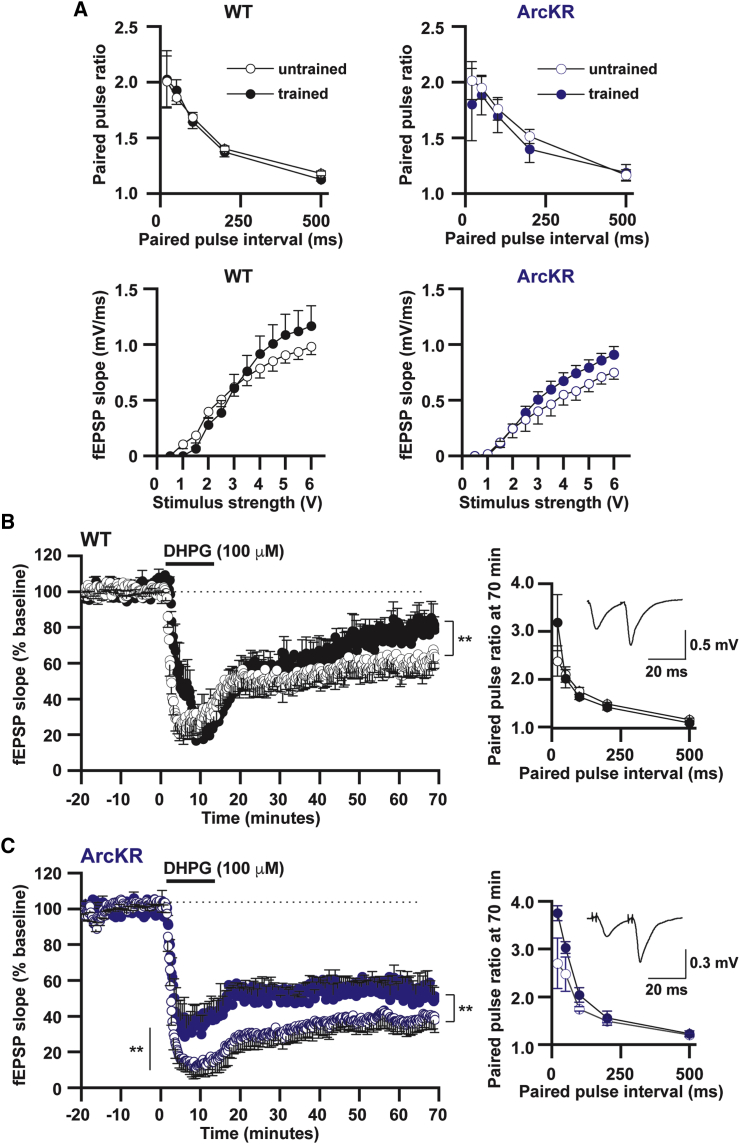
Reversal Learning Training Impacts on mGluR-LTD(A) Top panels: mean paired-pulse ratio (PPR) plotted against paired pulse interval for WT (untrained n = 8 slices; trained n = 10 slices) and ArcKR mice (untrained n = 8 slices; trained n = 10 slices). Bottom panels: graphs plotting mean fEPSP slope against stimulus strength for WT (untrained n = 6 slices; trained n = 7 slices) and ArcKR mice (untrained n = 6 slices; trained n = 8 slices).(B and C) Normalized mean fEPSP slope against time for WT (trained versus untrained) and ArcKR (trained versus untrained) mice. In WT and ArcKR mice, reversal learning significantly reduced mGluR-LTD (WT, reduction in fEPSP slope: untrained mice 39% ± 3.6%, n = 3, 7 slices; trained mice 21.3% ± 3.5%, n = 3, 6 slices, p = 0.0017; ArcKR, reduction in fEPSP slope untrained 59.9% ± 3.6%, n = 3, 7 slices; trained 47.3% ± 1.8%, n = 3, 6 slices, p = 3.9 × 10−13). Inset graphs: mean PPR plotted against paired-pulse interval for WT (untrained n = 8 slices; trained n = 10 slices) and ArcKR mice (untrained n = 8 slices; trained n = 10 slices) following LTD. Inset: traces at an interval of 20 ms from WT and ArcKR littermates. Values represent mean ± SEM. Statistical comparisons were carried out with a one-way ANOVA, paired and unpaired Student’s t tests.